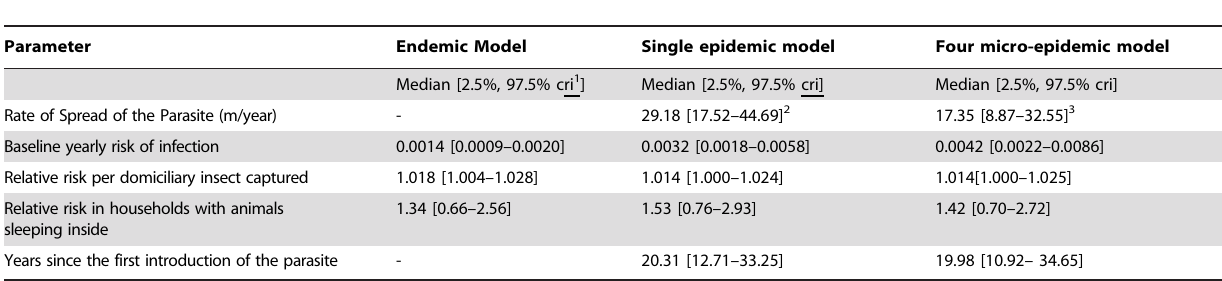
Table 1. Posterior estimates and credible intervals for endemic, single-epidemic and four micro-epidemic models of Trypanosoma cruzi transmission in peri-urban